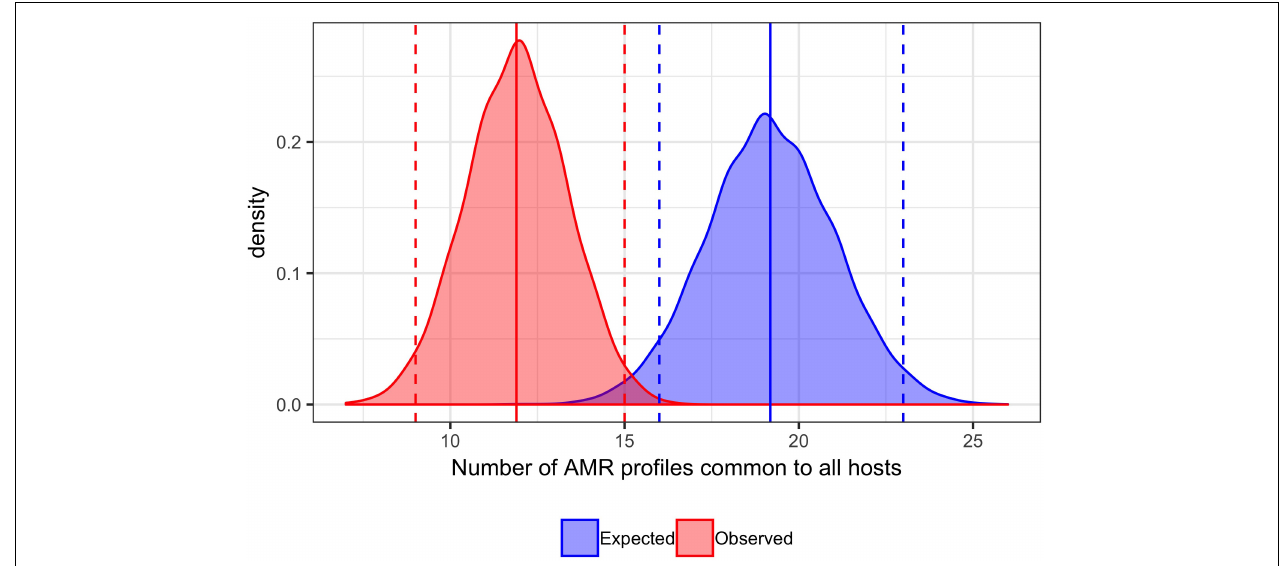
FIGURE 2 | Comparison of expected and observed number of unique AMR profiles common to cattle, pig and chicken host species. Distribution of 10,000 permutations of number of AMR profiles shared by all host species. Blue dashed vertical lines: first and last 2.5th percentiles of expected values (16,23). Blue solid vertical line: mean expected number of AMR profiles common to all hosts (19.19). Red dashed vertical lines: first and last 2.5th percentiles of observed values (9,15). Red solid vertical line: mean expected number of AMR profiles common to all hosts (11.87). Bandwidth 0.5.